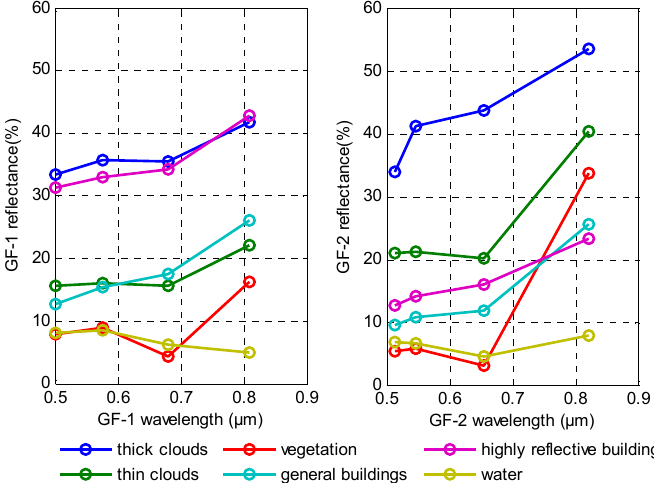
Figure 2. The mean reflectance spectra of thick clouds, thin clouds, vegetation, general buildings, highly reflective buildings, and water covered areas commonly found in GF-1/2 satellite images.